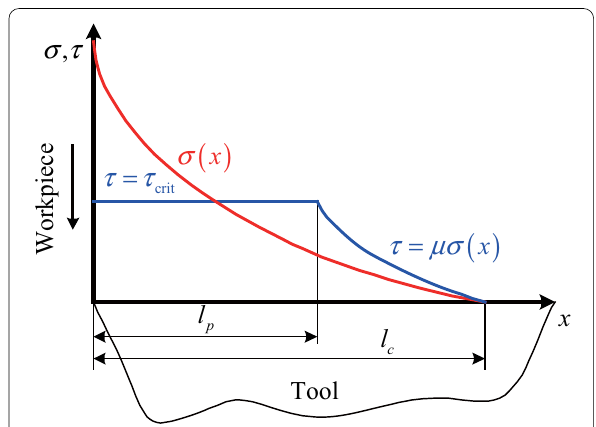
Figure 7 Distribution of normal stress and friction stress on the tool rake face